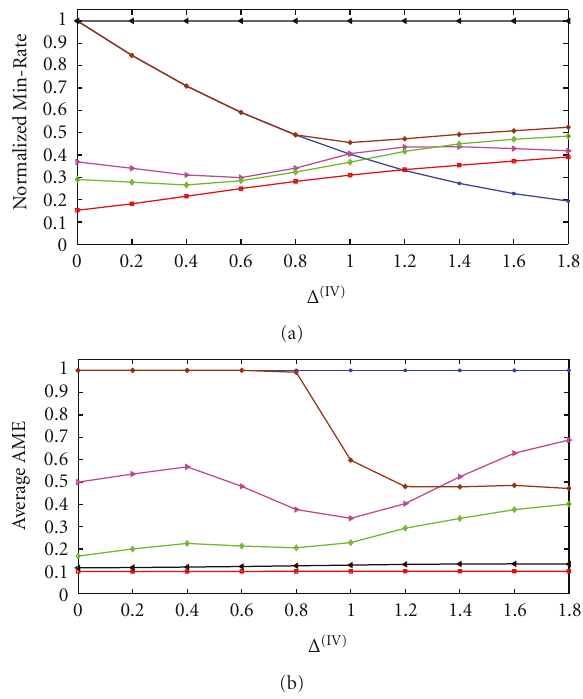
Figure 5: Experimental results for Model IV: (a) Normalized Min- Rate versus Δ (IV) ; (b) Average AME versus Δ (IV) . Note that Δ (IV) is not expressed in dB. The number of users ( K ), the number of runs ( N r ), and all graphical conventions are the same like in Figure